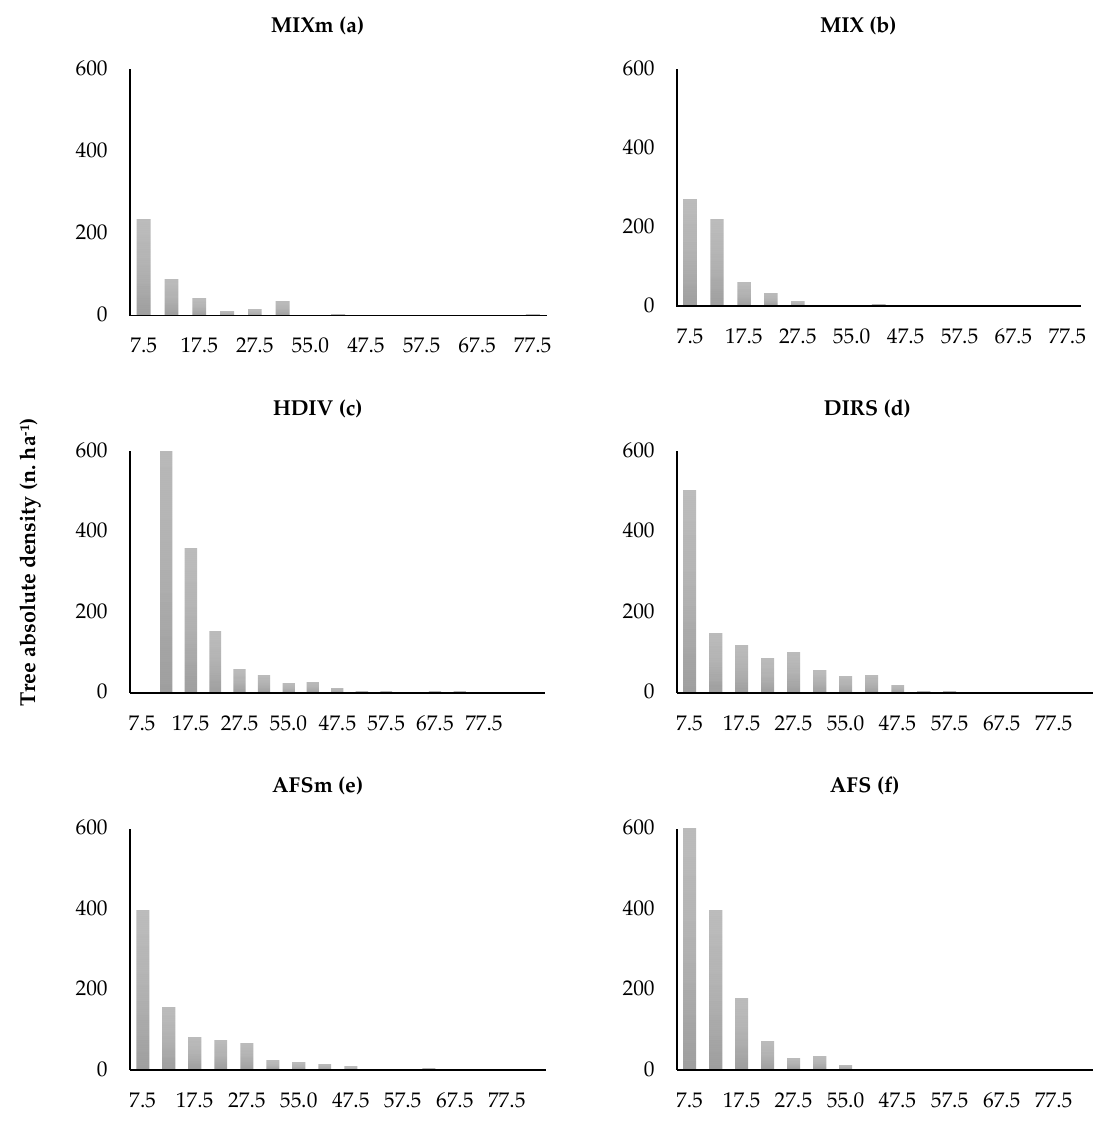
Figure 5. Tree absolute density (n. ha −1 ) as a function of DBH (diameter at breast height) classes of different restoration systems of the tropical semi-deciduous seasonal forest after 19–20 years of plantation at Botucatu, São Paulo. Labels: ( a ) MIXm (‘managed’ commercial mixed plantation), ( b ) MIX (commercial mixed plantation), ( c ) HDIV (high-diversity tree plantation), ( d ) DIRS (direct seeding, ( e ) AFSm (‘managed’ agroforestry system), ( f ) AFS (agroforestry system),). Analyses were performed for pooled sites data.